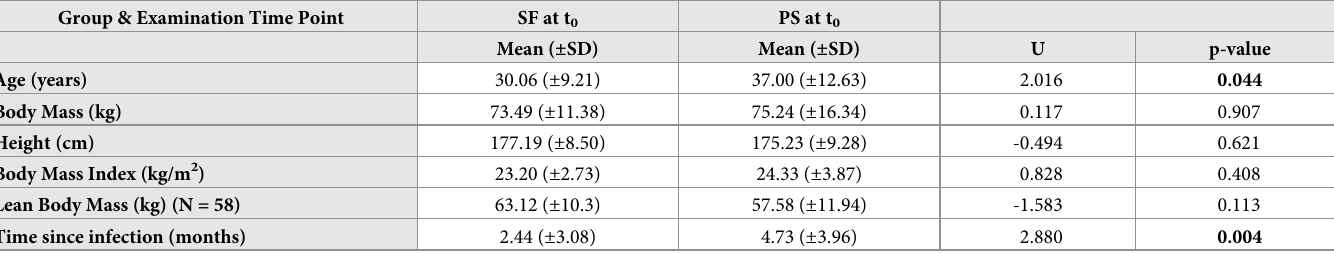
Table 2. Anthropometric data and test statistic for being a confounder in SF (symptom-free) and PS (persistent symptoms) at t 0 (first examination date). Group & Examination Time Point